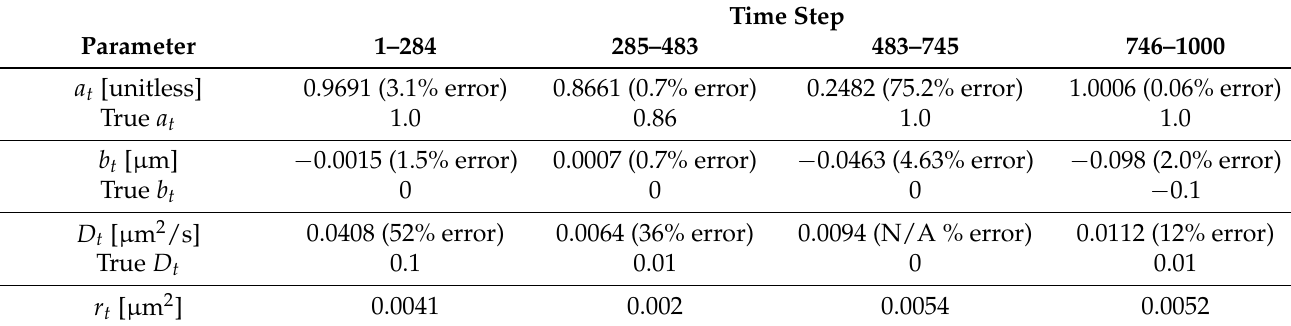
Table 2. Estimated motion parameter values and percent error from ground truth.